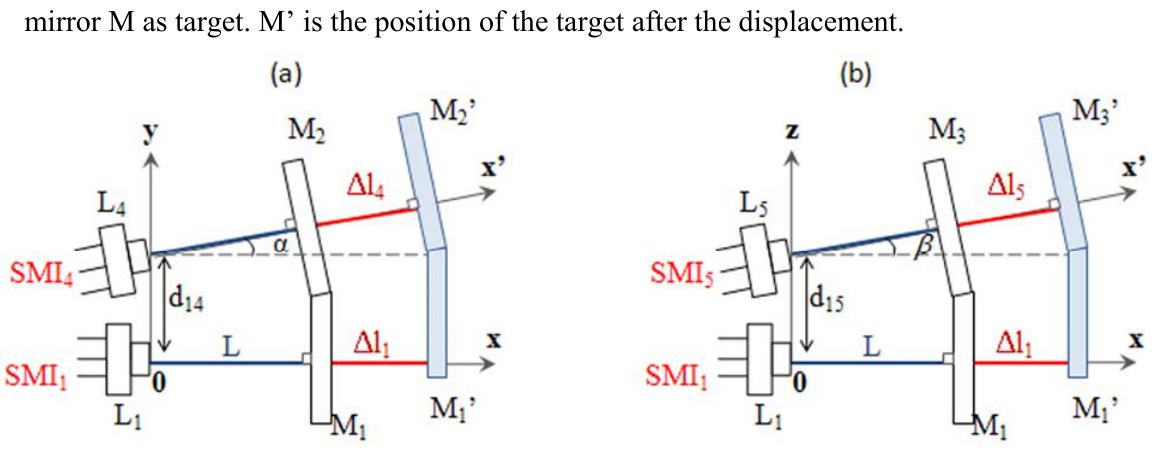
(i = 1,4,5) is made of a laser diode L i